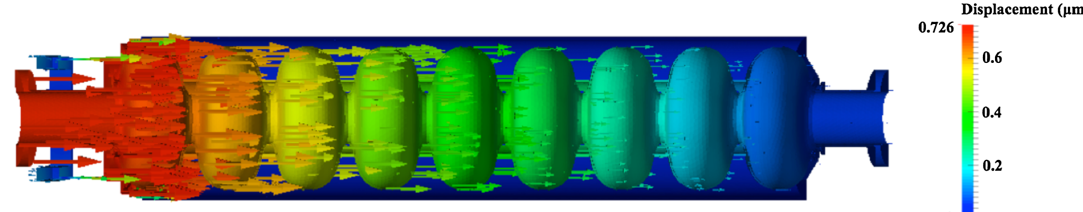
FIG. 10. Direction and magnitude of the structural displacements due to a static piezoload.